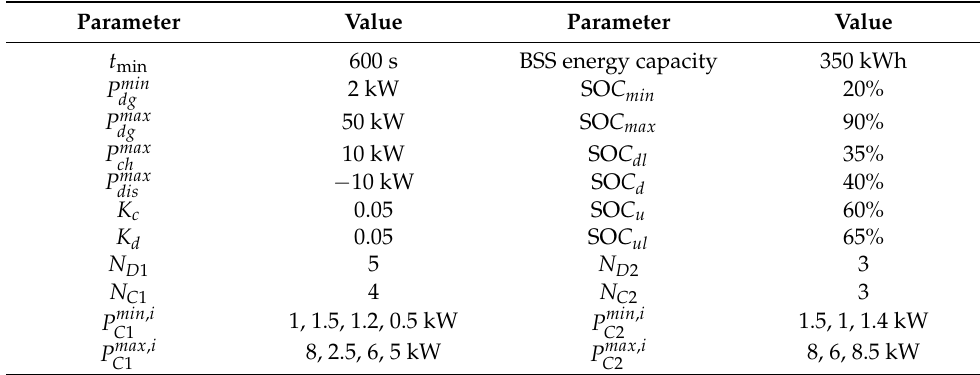
Table 4. Parameters of the considered system for tests. Parameter Value Parameter Value t min 600